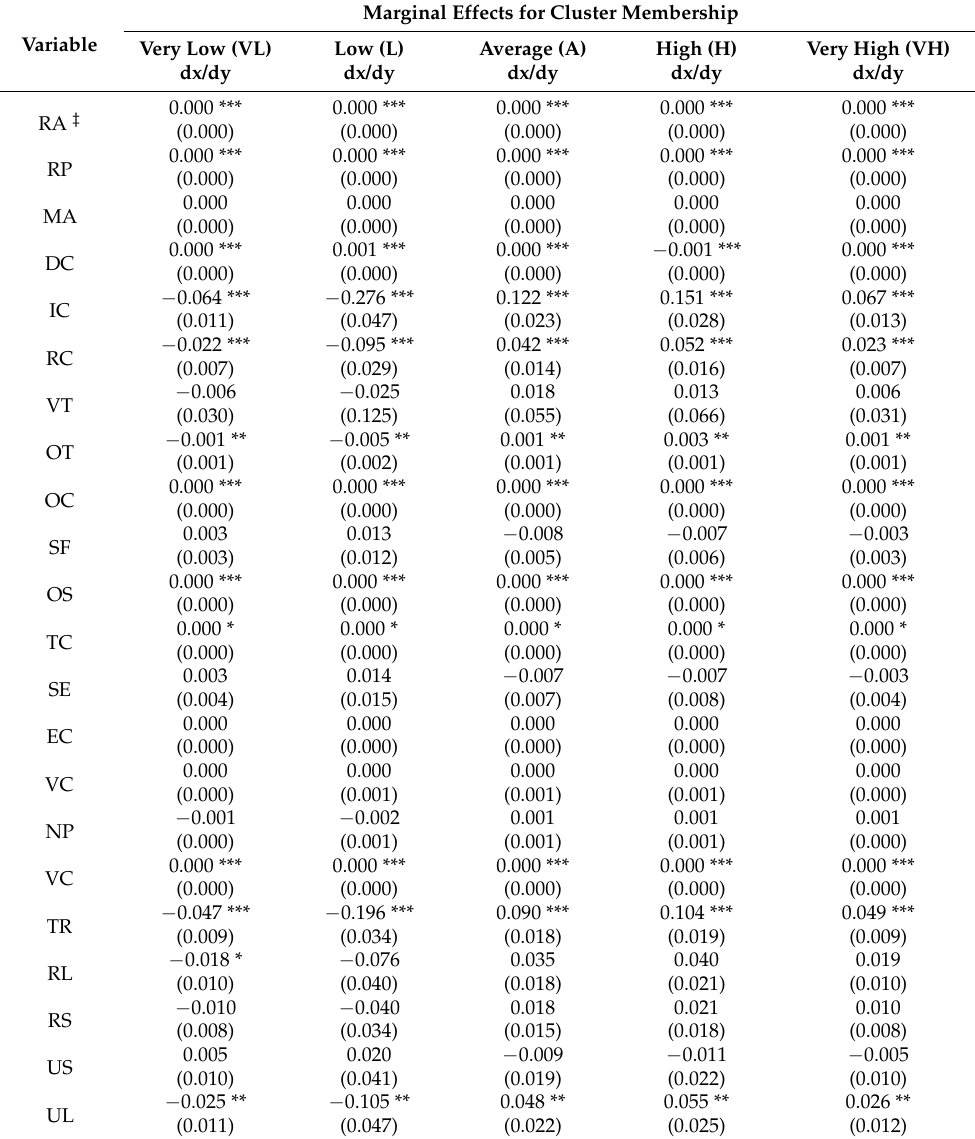
Table 8. Marginal effects for multinomial ordered logit model with dependent variable—territorial cohesion index value in 2017 divided into 5